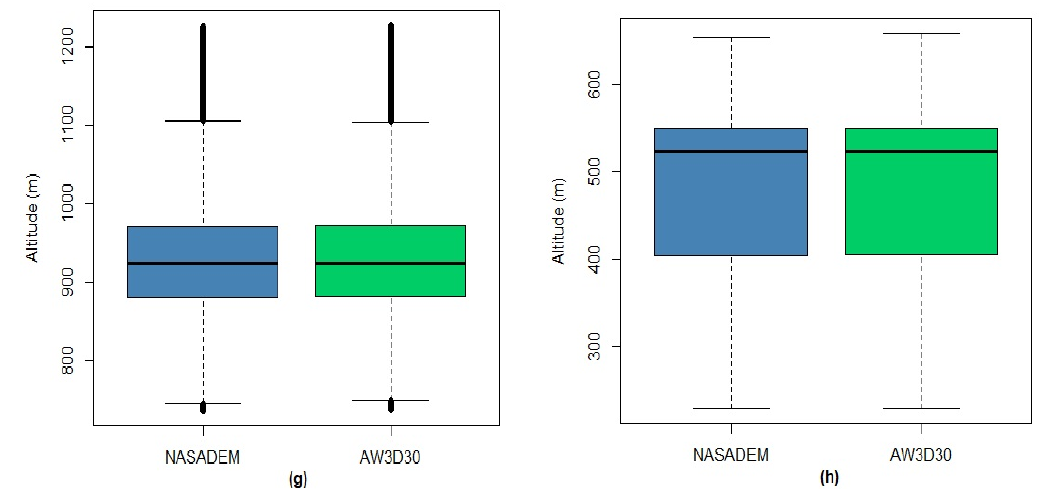
Figure 8. Boxplots of the NASADEM_HGT and AW3D30 digital elevation models for the agricultural areas of Sapezal ( a ), Rio Verde ( b ), São Desidério ( c ), Maracaju ( d ), Formosa do Rio Preto ( e ), Primavera do Leste ( f ), Cristalina ( g ), and Balsas ( h ) municipalities.